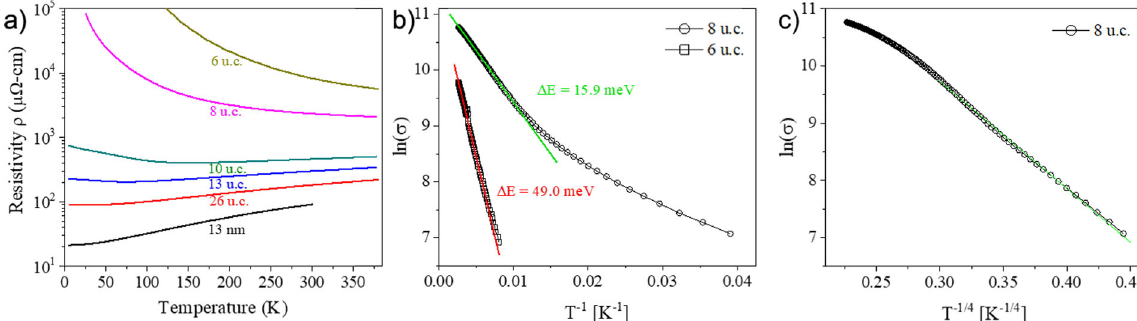
Fig. 3 Temperature-dependent electronic transport data for (111)-oriented LaNiO 3 . a Resistivity versus temperature for 6 u.c. to 13-nm- thick fi lms. b Arrhenius thermal activation of carriers fi t the high-temperature data for insulating samples. c 3D variable-range hopping fi t to low-temperature data for insulating samples. The samples became too insulating to measure at 125 K for the 6 u.c. sample and at 25 K for the 8 u.c.